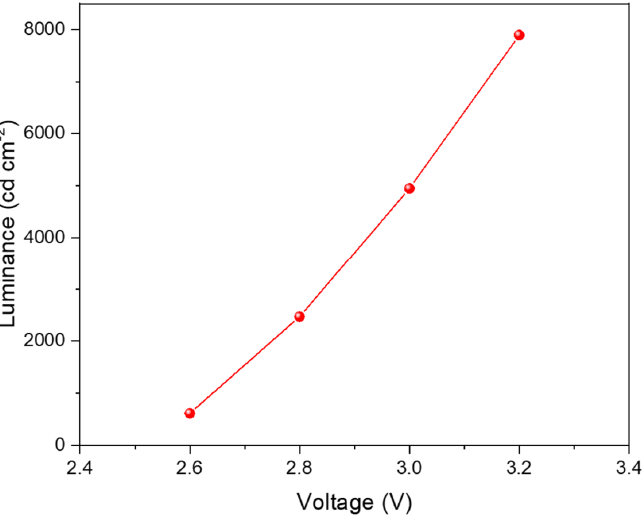
Figure 10. The luminance of SBA-15@CsPbBr 3 QD-LED at different voltage.